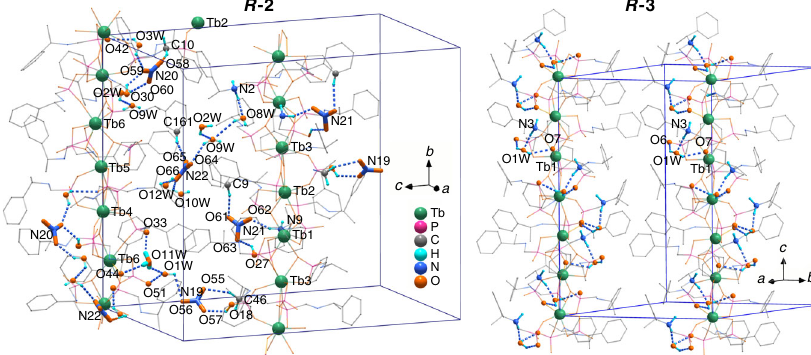
Fig. 4 Hydrogen bonds in R -2 and R -3 . Hydrogen bonds for NO 3 − anions, H 3 O + cations, and/or lattice water molecules are highlighted